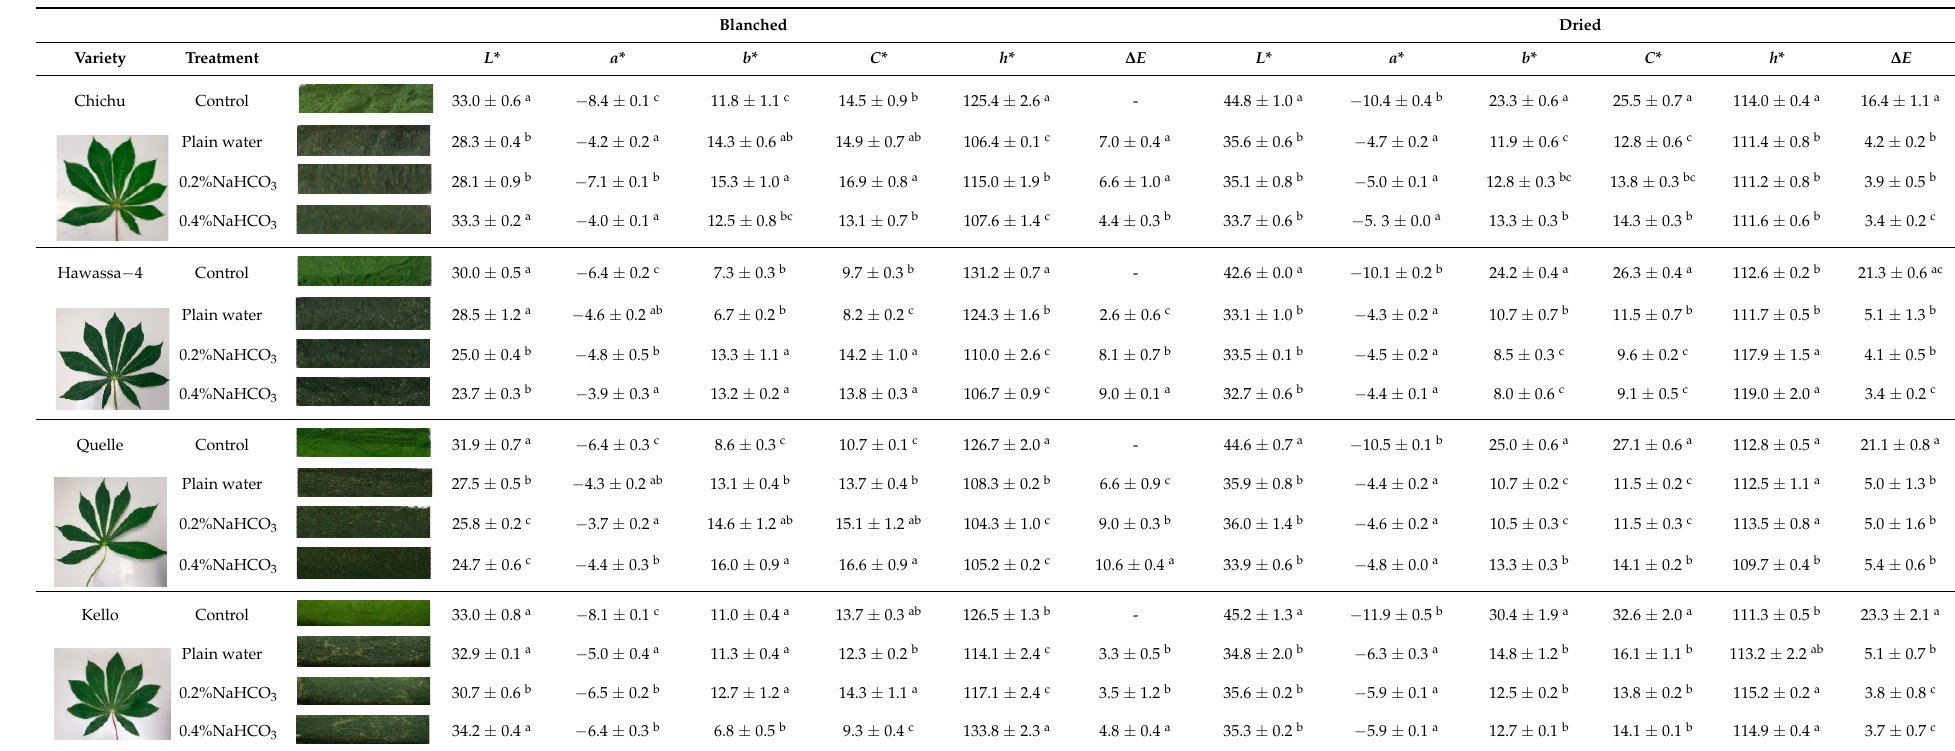
Table 1. Effect of blanching and drying on the color quality of different cassava varieties .